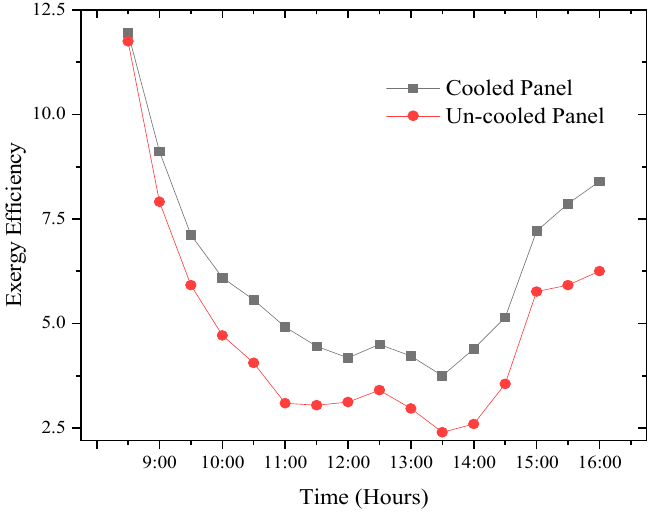
Figure 15. Time-dependent exergy efficiency.